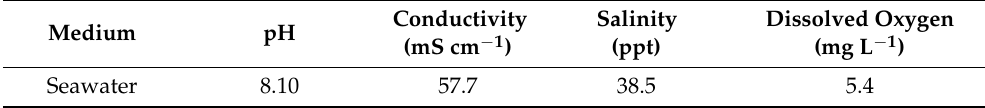
Table 2. The physical parameters of the seawater used for the experiments.